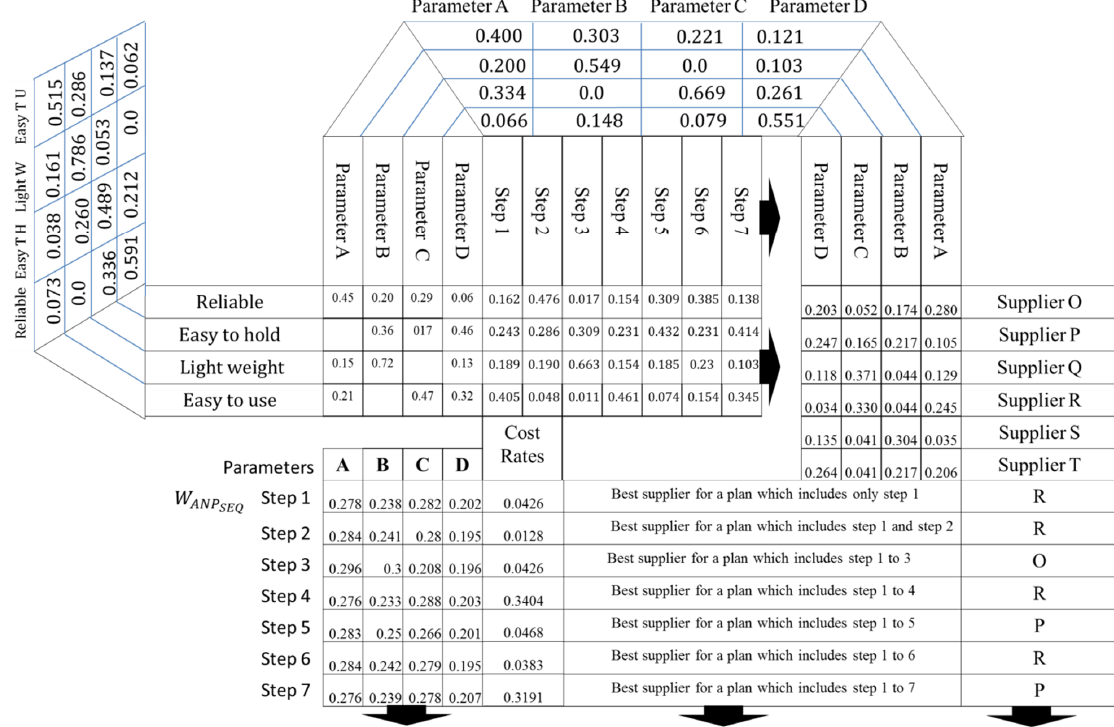
Fig. 2. The hybrid-QFD for the supplier selection process (the